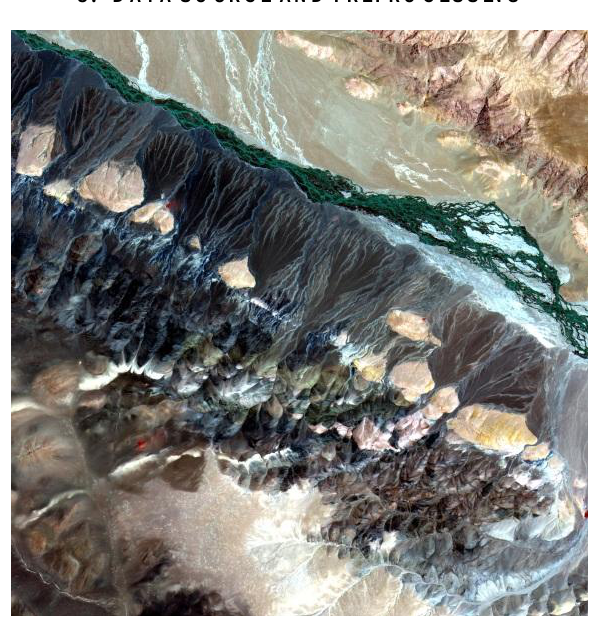
Figure 2 843 band combination